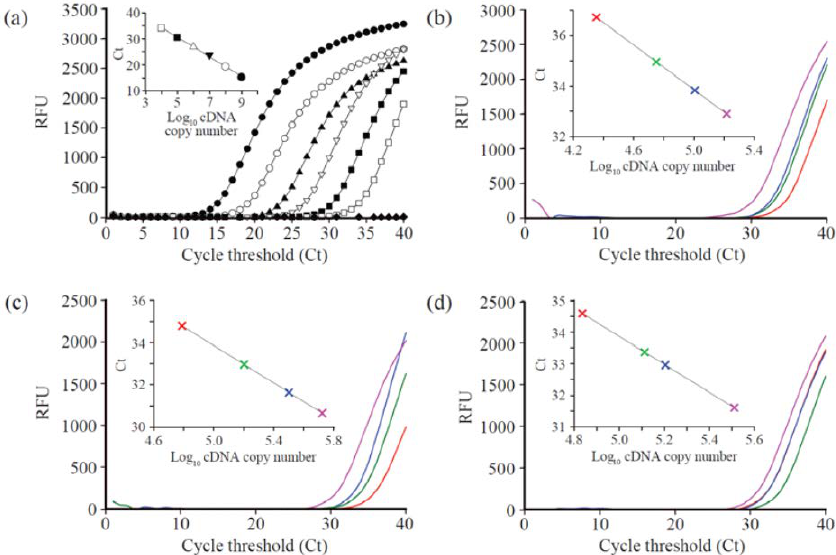
Figure 1. Genotoxicity of MgO nanoparticles on expression of GST in HepG2 cells. ( a ) RT-PCR profiles with serially diluted cDNA as a template (● 1.0 × 10 9 , ○ 1.0 × 10 8 , 1.0 × 10 6 , ■ 1.0 × 10 5 , □ 1.0 × 10 4 , ♦ blank) and the calibration curve ▼ 1.0 × 10 7 , of cDNA copy number with respect to the corresponding C t values (inset). The enlarged △ RT-PCR profiles depend on the MgO nanoparticle incubation time of ( b ) 24 h, ( c ) 48 h and ( d ) 72 h, and MgO concentrations (red: control, green: 25 µg/mL, blue: 75 µg/mL, pink: 150 µg/mL).